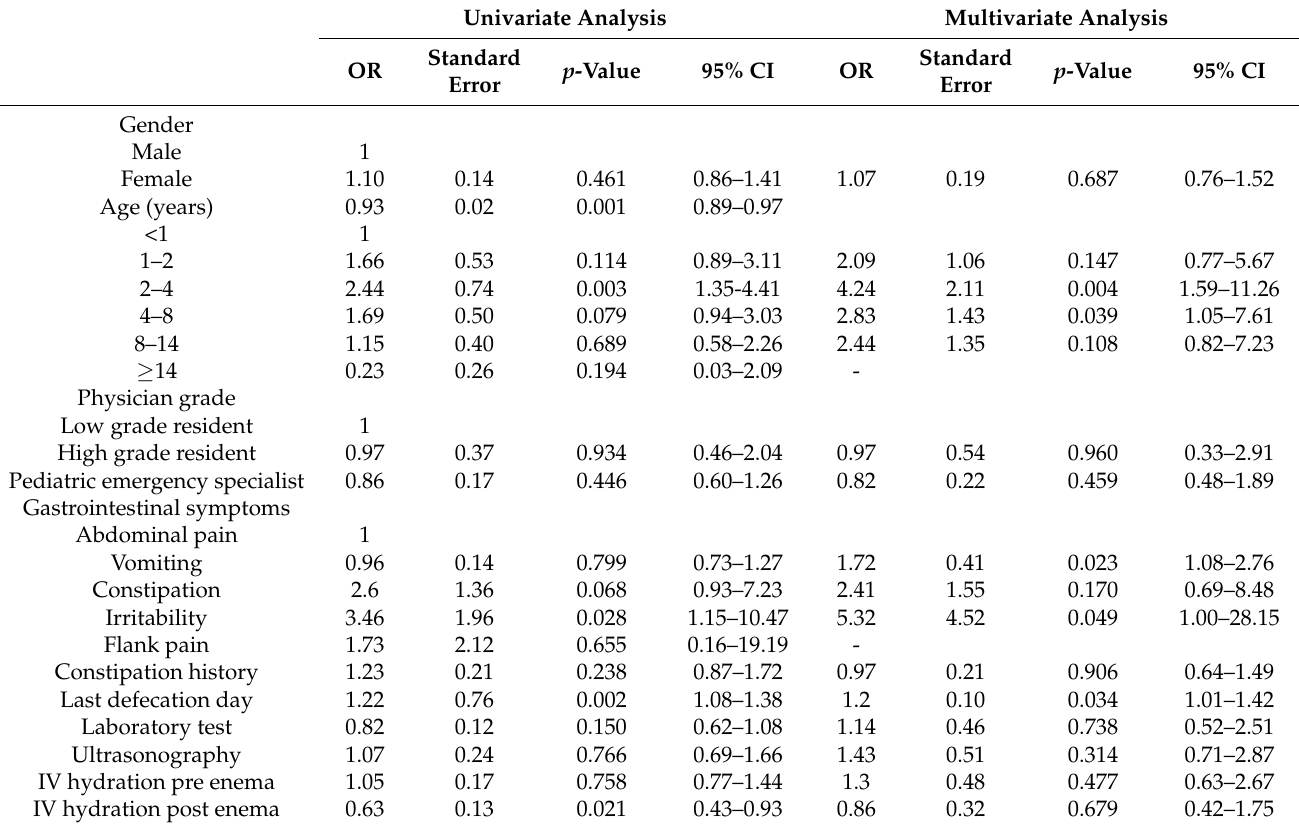
Table 2. Variables associated with the appropriate decision to do a glycerin